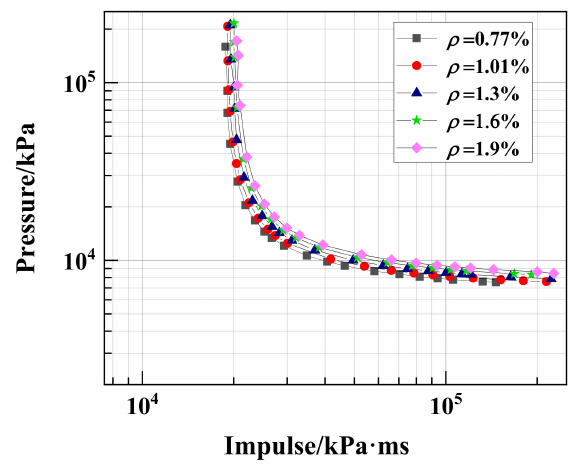
Figure 22. P-I curves of shear response with different longitudinal reinforcement